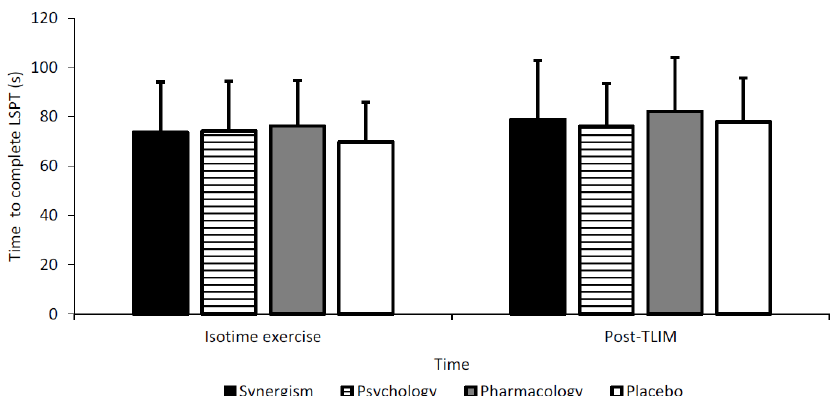
Figure 4. Time taken to complete the Loughborough Soccer Passing Test (LSPT) across treatments and time.